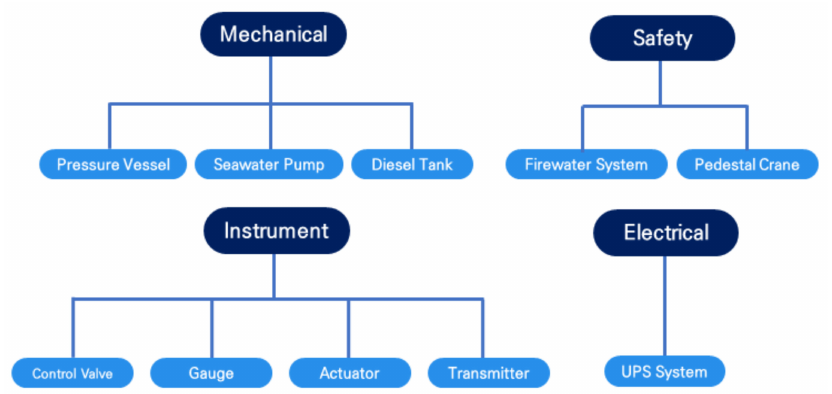
Figure 12. Hierarchy of standard design parameters—10 pieces of